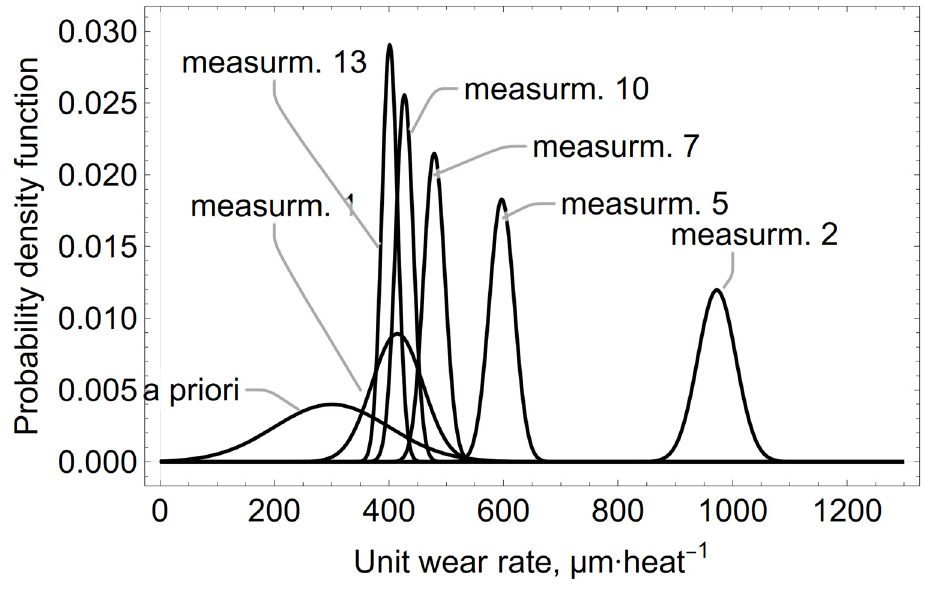
Figure 7. The Bayesian evolution of the mean value of µ µm heat − 1 unit wear rate of MC 95/10 refractory material in the spout zone, calculated for selected measurements: 1, 2, 5, 7, 10, 13.